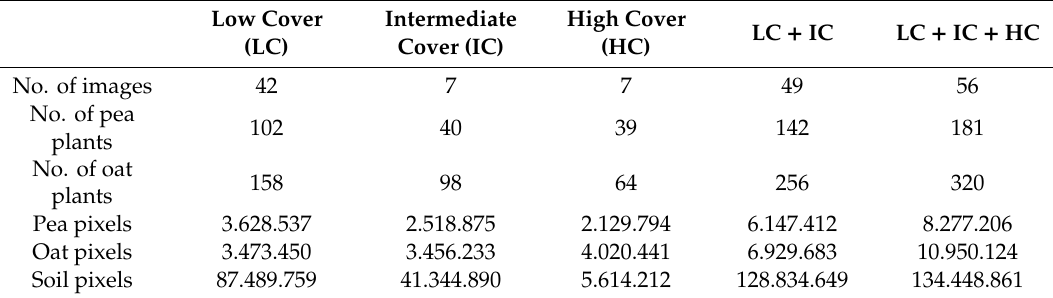
Table 2. Description of the training input for the five networks.